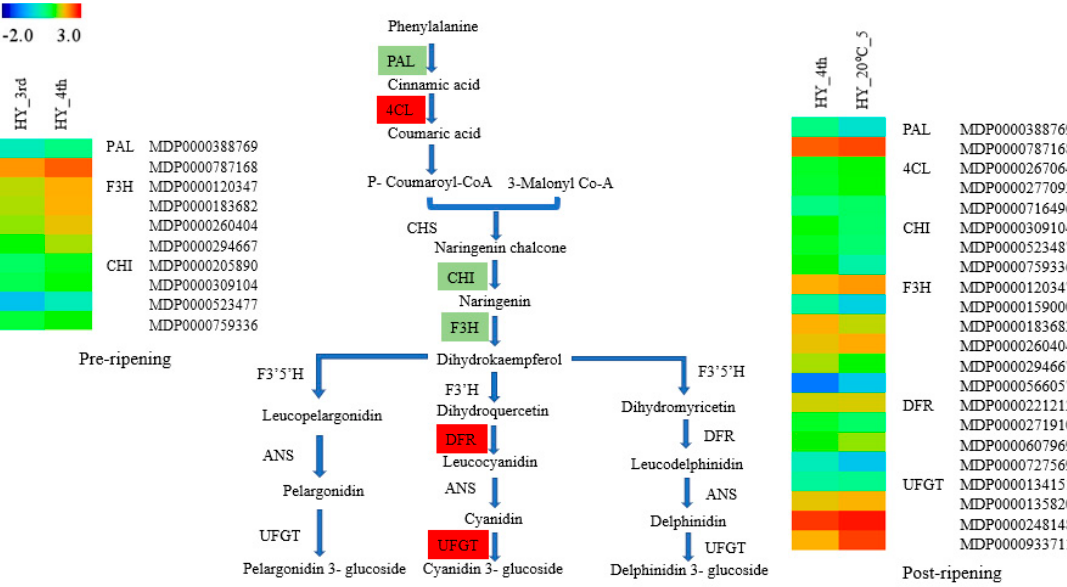
Figure 7. Heat map represents DEGs involved in anthocyanin biosynthesis pathway in pre (HY_4th vs. HY_3rd) and post (HY_20 °C_5 vs. HY_4th) ripening groups. Genes remarked with light green color denotes expression in both groups and red color denotes expressed in the post ‐ ripening group only. PAL (Phenylalanine ammonia ‐ lyase); 4CL (4 ‐ coumarate ‐ CoA ligase); CHS (Chalcone Synthase); CHI (Chalcone isomerase); F3H (Flavanone 3 ‐ hydroxylase); F3 ′ H (Flavanone 3 ′‐ hydroxylase); DFR (Dihydroflavonol 4 ‐ reductase); ANS (Anthocyanidin synthase) and UFGT (UDP glucose: flavonol 3 ‐ O ‐ glucosyltransferase).